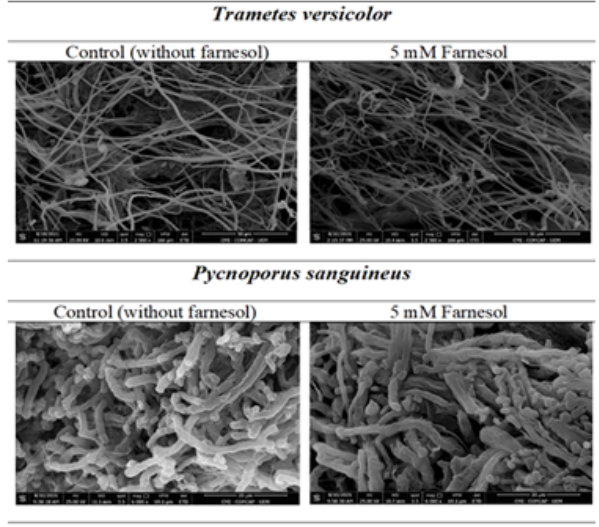
Figure 4. SEM analysis of T. versicolor and P. sanguineus hyphae. Fungi were grown in the absence (control) and presence of 5 mM of farnesol.